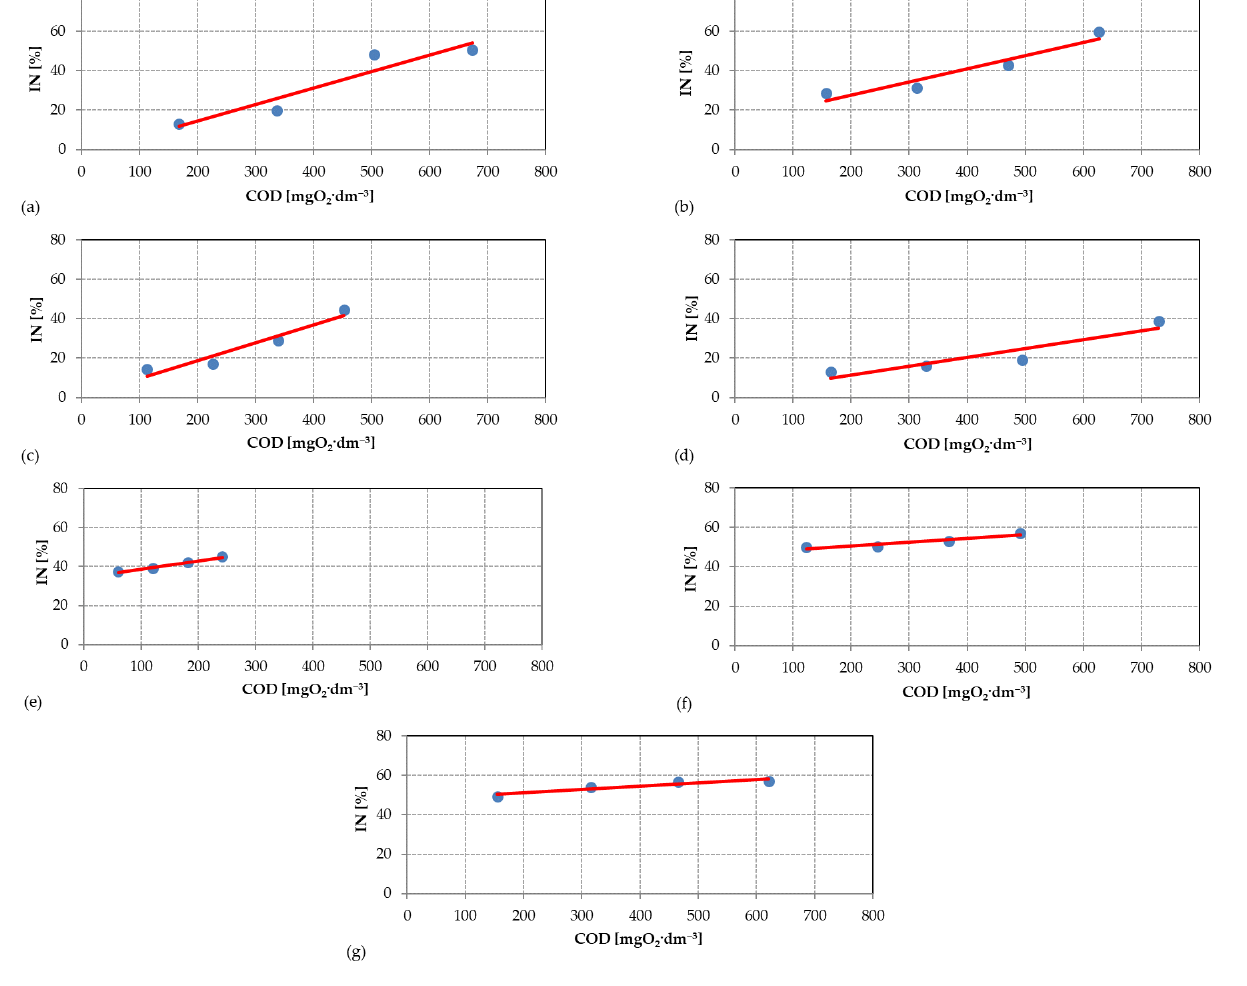
Figure 1. Scatterplots of measurement data from laboratory tests against established regression lines: ( a ) wastewater from acrylonitrile rubber production; ( b ) wastewater from styrene–butadiene rubber production; ( c ) wastewater from emulsifier production; ( d ) wastewater from polyvinyl acetate production; ( e ) wastewater from styrene production; ( f ) wastewater from solvent (butyl acetate, ethyl acetate) production; ( g ) wastewater from owipian ®